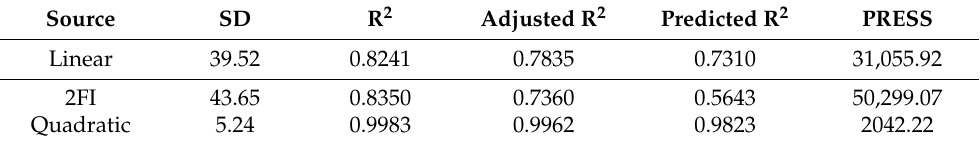
Table 3. Model summary statistics for selection of the best fitting model for the particle size of PIC-BZ. Source SD R 2 Adjusted R 2 Predicted R 2 PRESS Linear 39.52